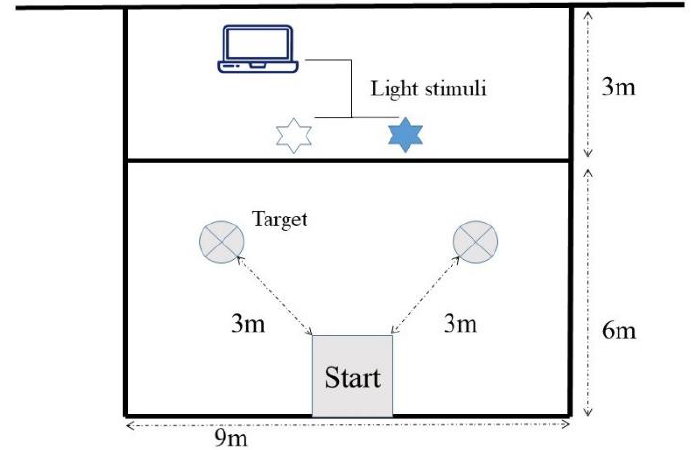
Figure 3. Diagram of the digging agility test for volleyball.